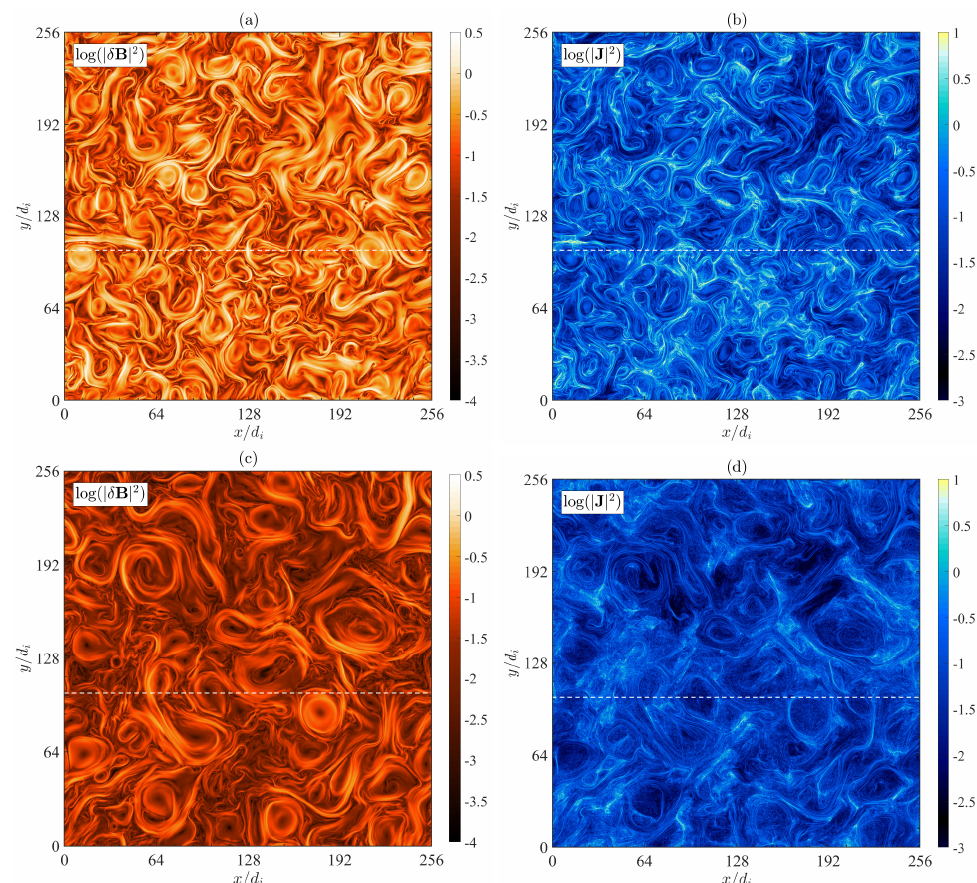
Figure 1. Contour plots of the logarithm of the magnitude of the magnetic fluctuations, | δ B | 2 = | B − B 0 | 2 , and of the current density, | J | 2 , for Run 1 (( a , b ), respectively) and for Run 2 (( c , d ), respectively), at their respective time of maximum turbulent activity. The white horizontal dotted lines mark 1D cuts that we analyse in Figures 2 and